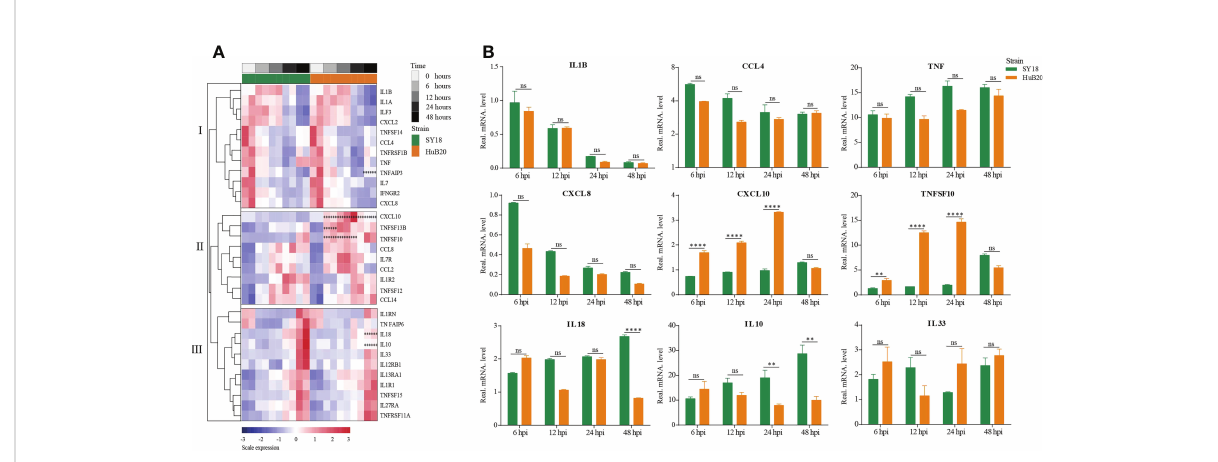
FIGURE 5 Patterns of cytokines changes and chemokines expression in PAM at different times after ASFV infection. (A) Heatmap of cytokines and chemokines expression after ASFV infection. cytokines and chemokines were divided into 3 clusters according to distinct patterns in expression over time. Dots illustrate the signi fi cance compared between two strains at the same time point with constraints the absolute value of log 2 foldchange > 1 and P < 0.1 . *, P < 0.1 ; **, P < 0.05 ; ***, P < 0.01 , ns, not signi fi cant. (B) Validation of randomly selected host cytokines and chemokines expression by real time-PCR at 6, 12, 24, and 48 h after PAMs infected by two ASFV strains (MOI= 3). Data are presented as mean ± SD of three independent experiments. The fold-difference was measured by the 2-DDCt method. Differences were assessed using a two- sample t-test. Signi fi cance was de fi ned at P < 0.05 and log 2 foldchange >1. ** P < 0.01 ; *** P < 0.001 , **** P < 0.0001 , ns, not signi fi